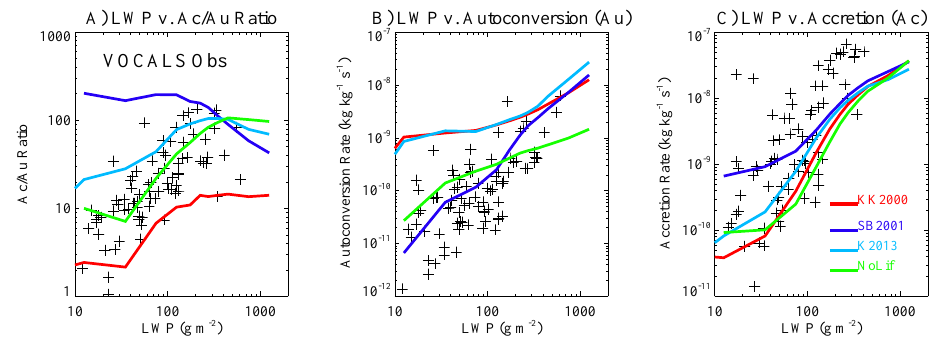
Figure 9. 60 ◦ S to 60 ◦ N latitude (a) ratio of accretion to autoconversion, (b) autoconversion rate and (c) accretion rate using KK2000 (red), SB2001 (dark blue), K2013 (cyan) autoconversion and the no lifetime (NoLif) simulation (green). Estimates derived from observations from the VOCALS experiment shown as black crosses (see text for